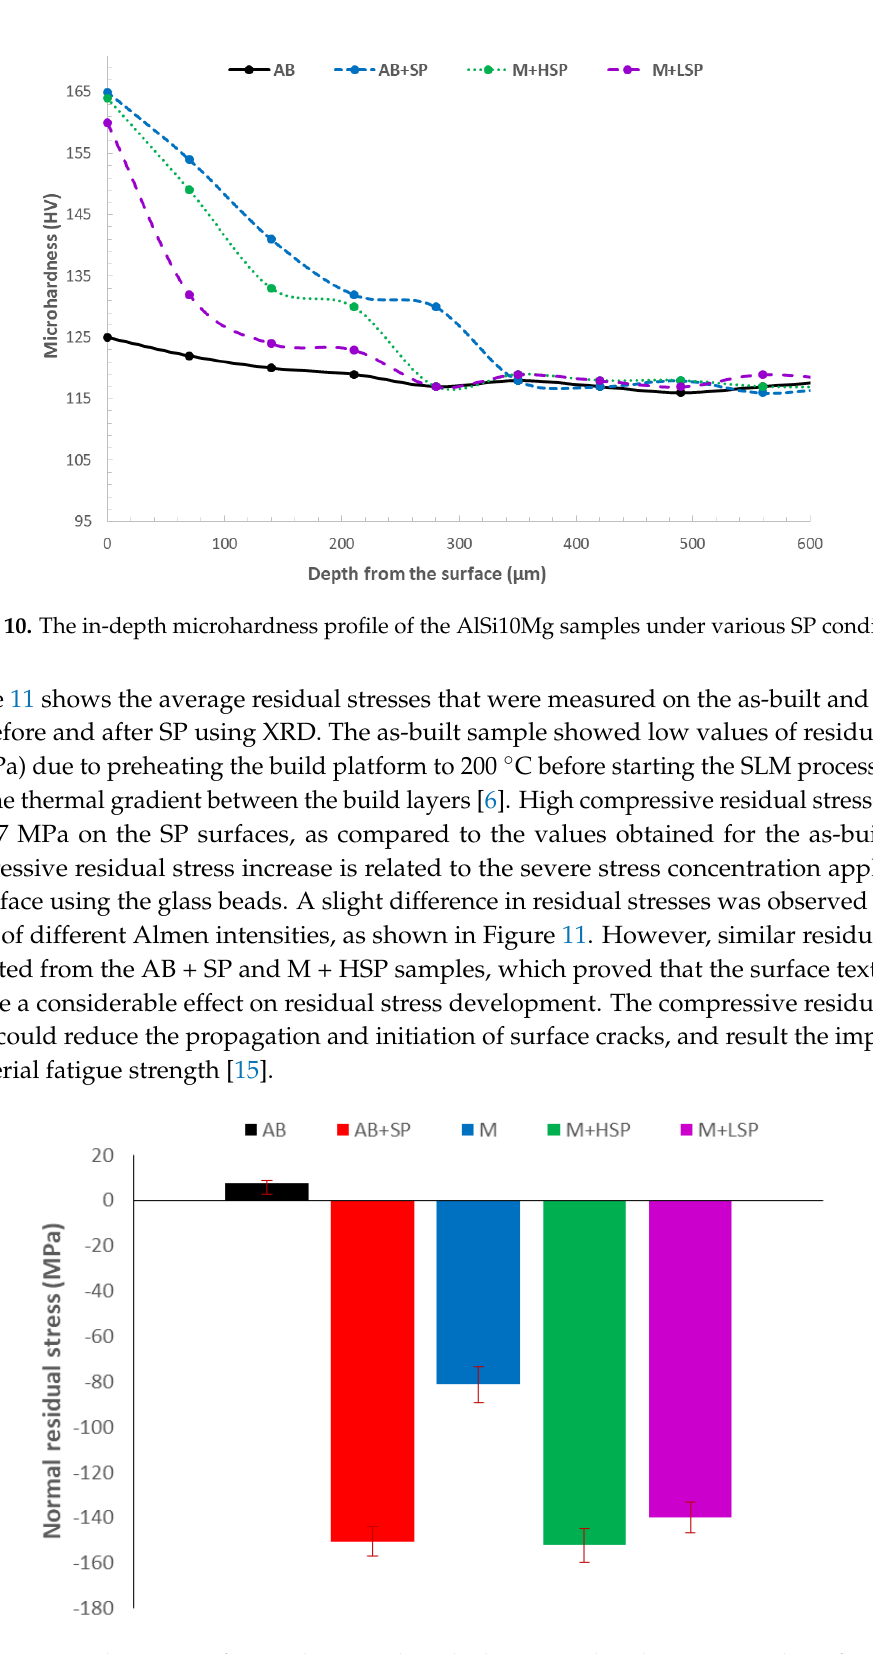
Figure 11. The impact of SP on the normal residual stress on the AlSi10Mg sample surface.